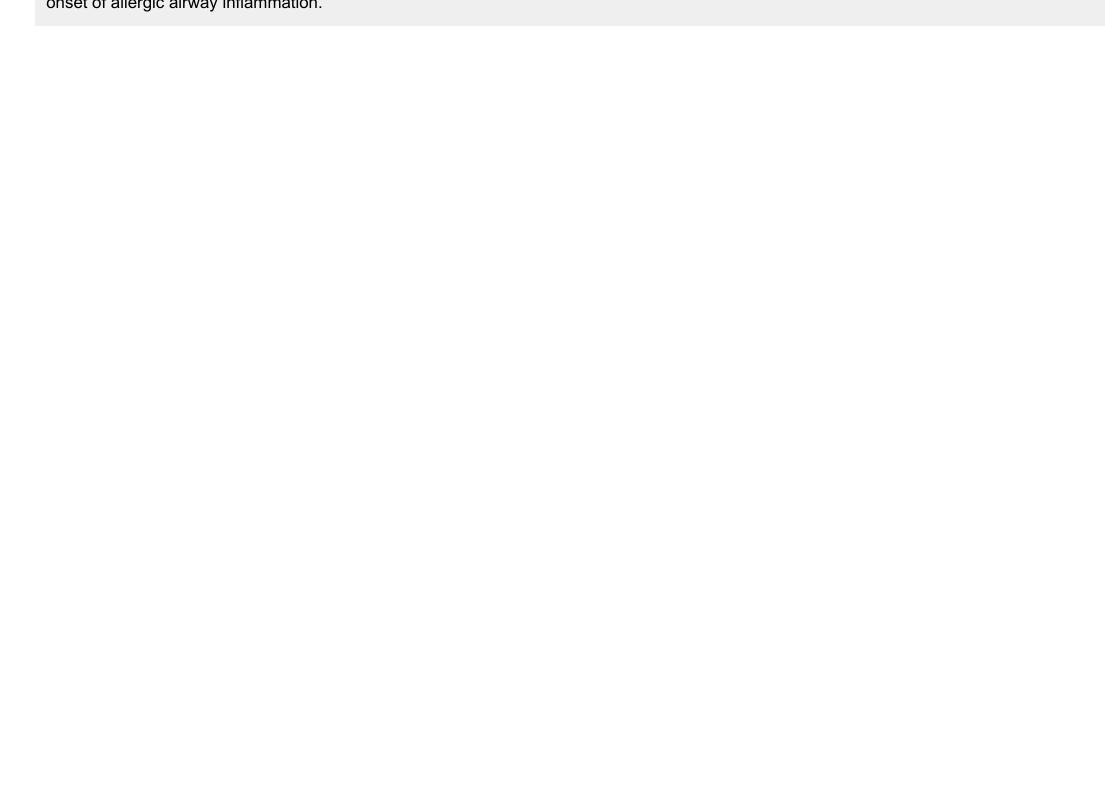
Figure 2 Overview of interactions between surfactant protein-D and immune effector cells, which orchestrate the pulmonary immune response during the onset of allergic airway